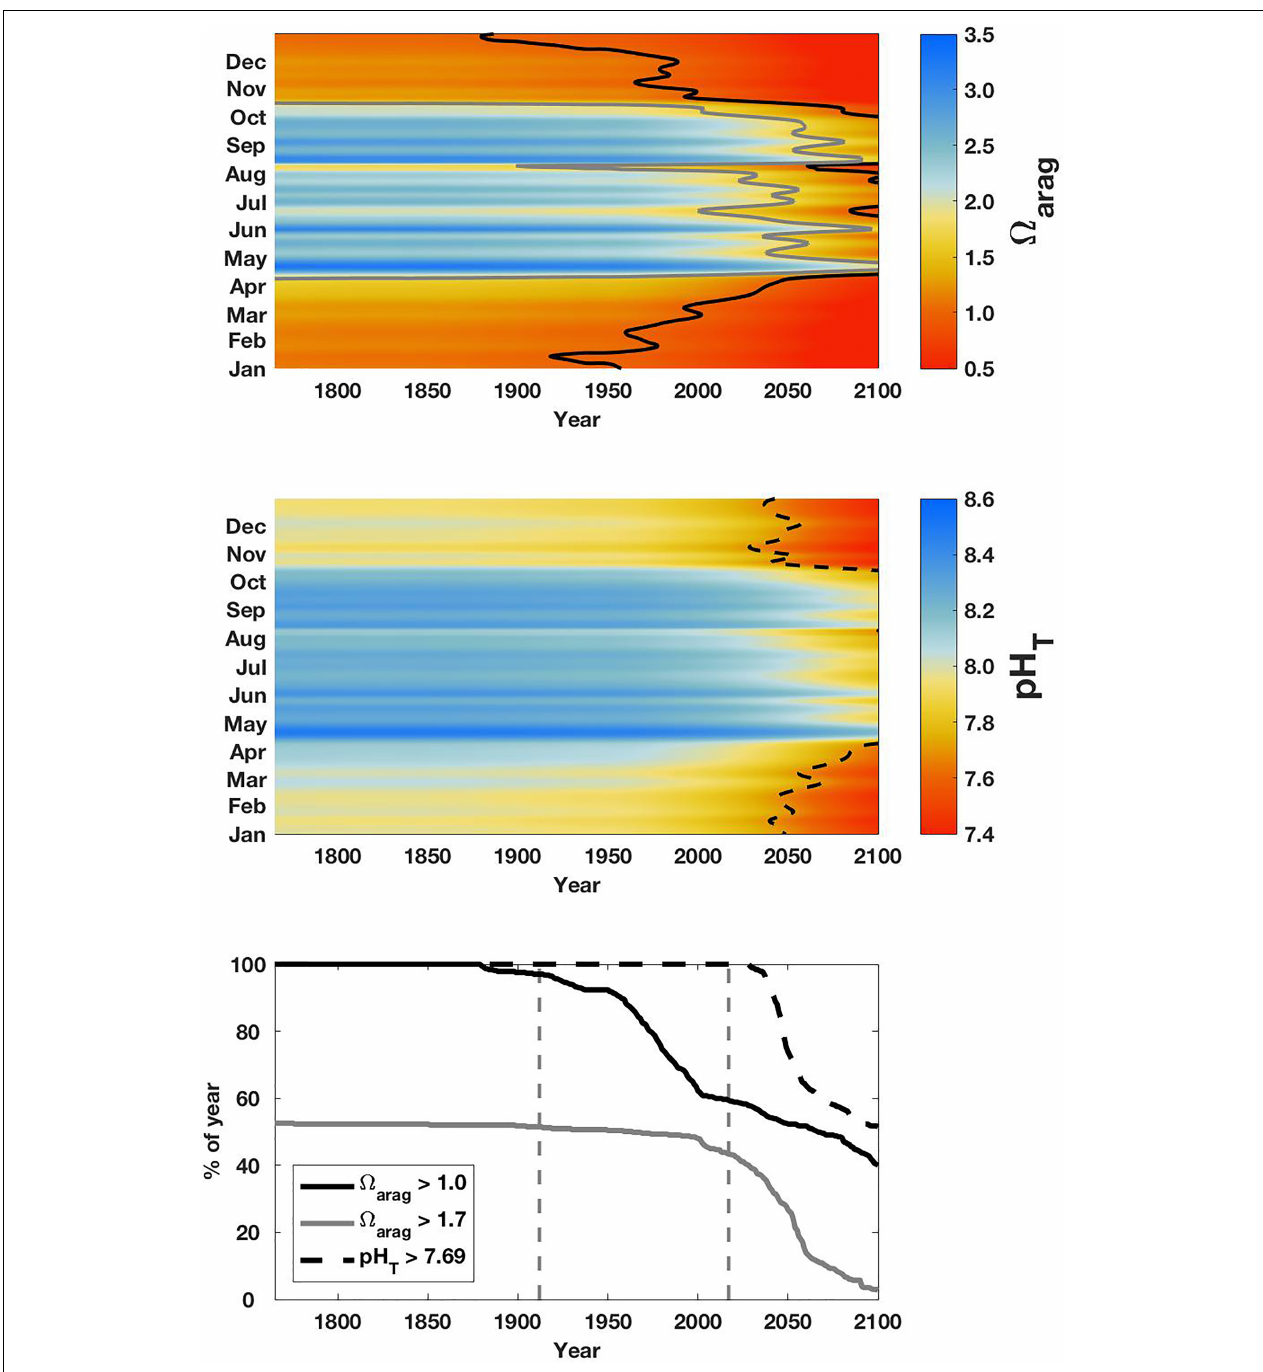
FIGURE 9 | Projections from 1765 to 2100 of surface water (cid:127) arag (top) , pH T (middle) , and the percent of the year with values above key thresholds (bottom): (cid:127) arag = 1 (black), (cid:127) arag = 1.7 (gray), and pH T = 7.69 (dashed black). These thresholds are highlighted in the upper panels. 2017 QIFS data used in these projections were smoothed using a 14-day LOESS